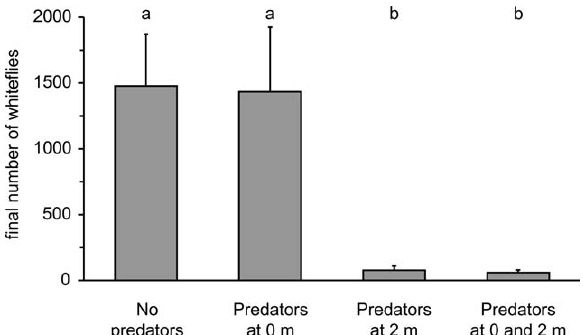
Figure 4. The average number of adult whiteflies ( + s.e.m.) on all five plants at the end of the experiment (after 28 days). Symbols above the bars indicate significant differences. Whitefly numbers were significantly higher in treatments in which predators were not released on the same plant as the whiteflies (left-hand two bars) than in treatments where predators and whiteflies were released on the same